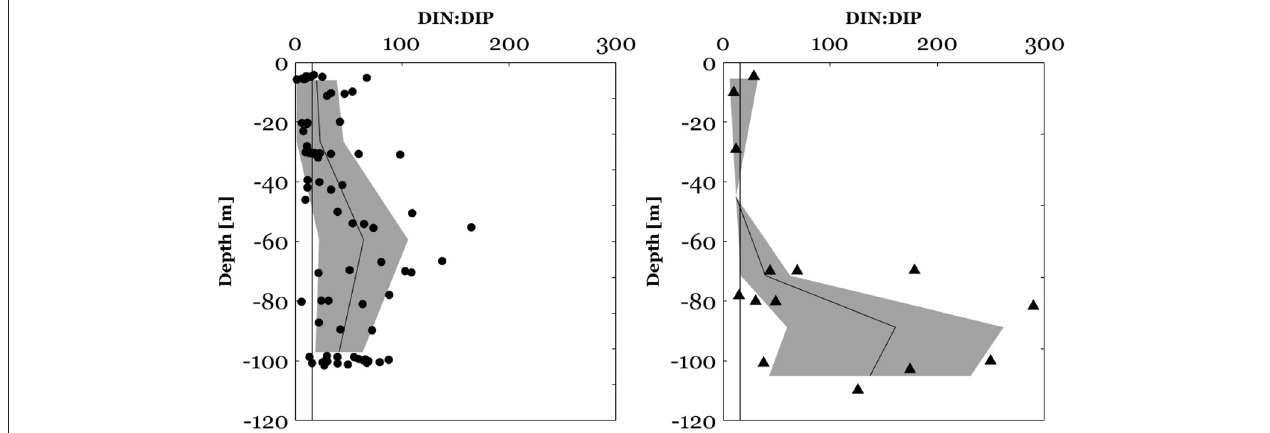
FIGURE 7 | DIN:DIP molar ratios between the surface and 100m in the NWMS (circles) and DIN:DIP ratios between the surface and 120m along the E-W transect (triangles). The black plot represents the mean depth profile of the DIN:DIP ratio, the bounded line the standard deviation from the mean and the dark vertical line the Redfield molar ratio of 16:1.